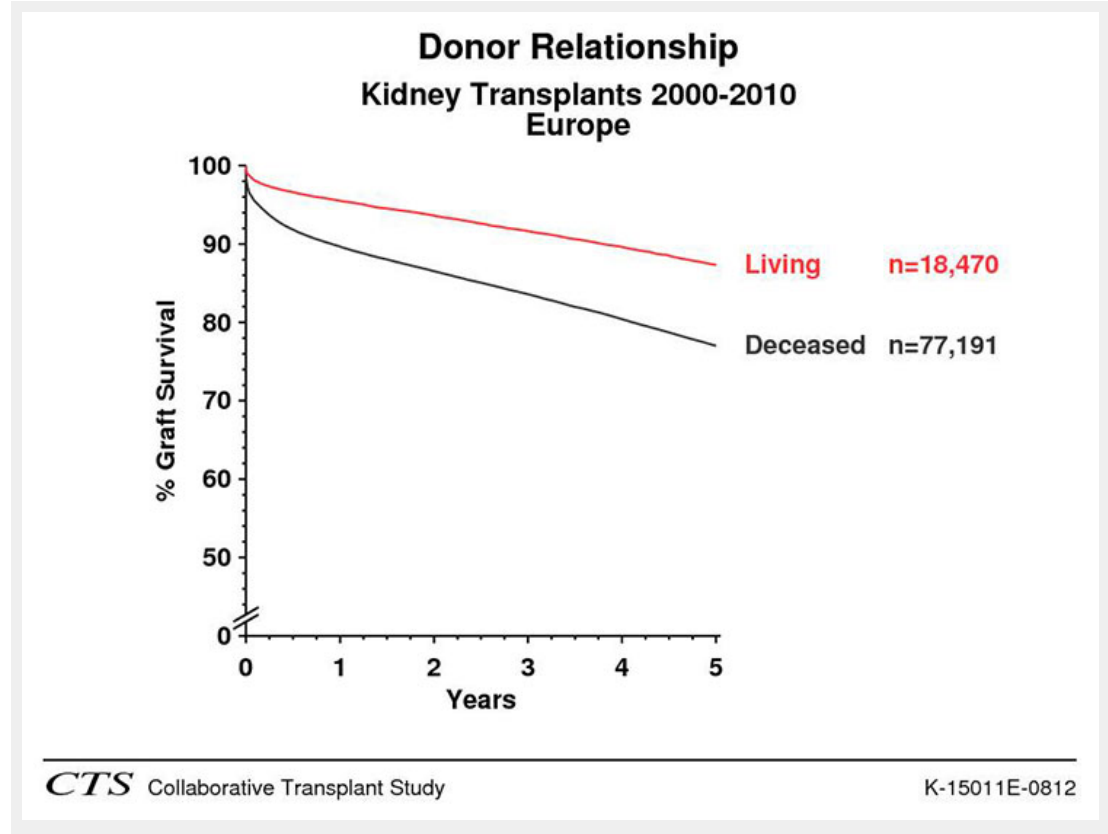
Figure 4 Comparison of graft survival between living donated kidneys and kidneys from deceased donors in Europe between 1998 and 2010 (CTS K-15011E-0212). (Source: http://www.ctstransplant.org, with kind